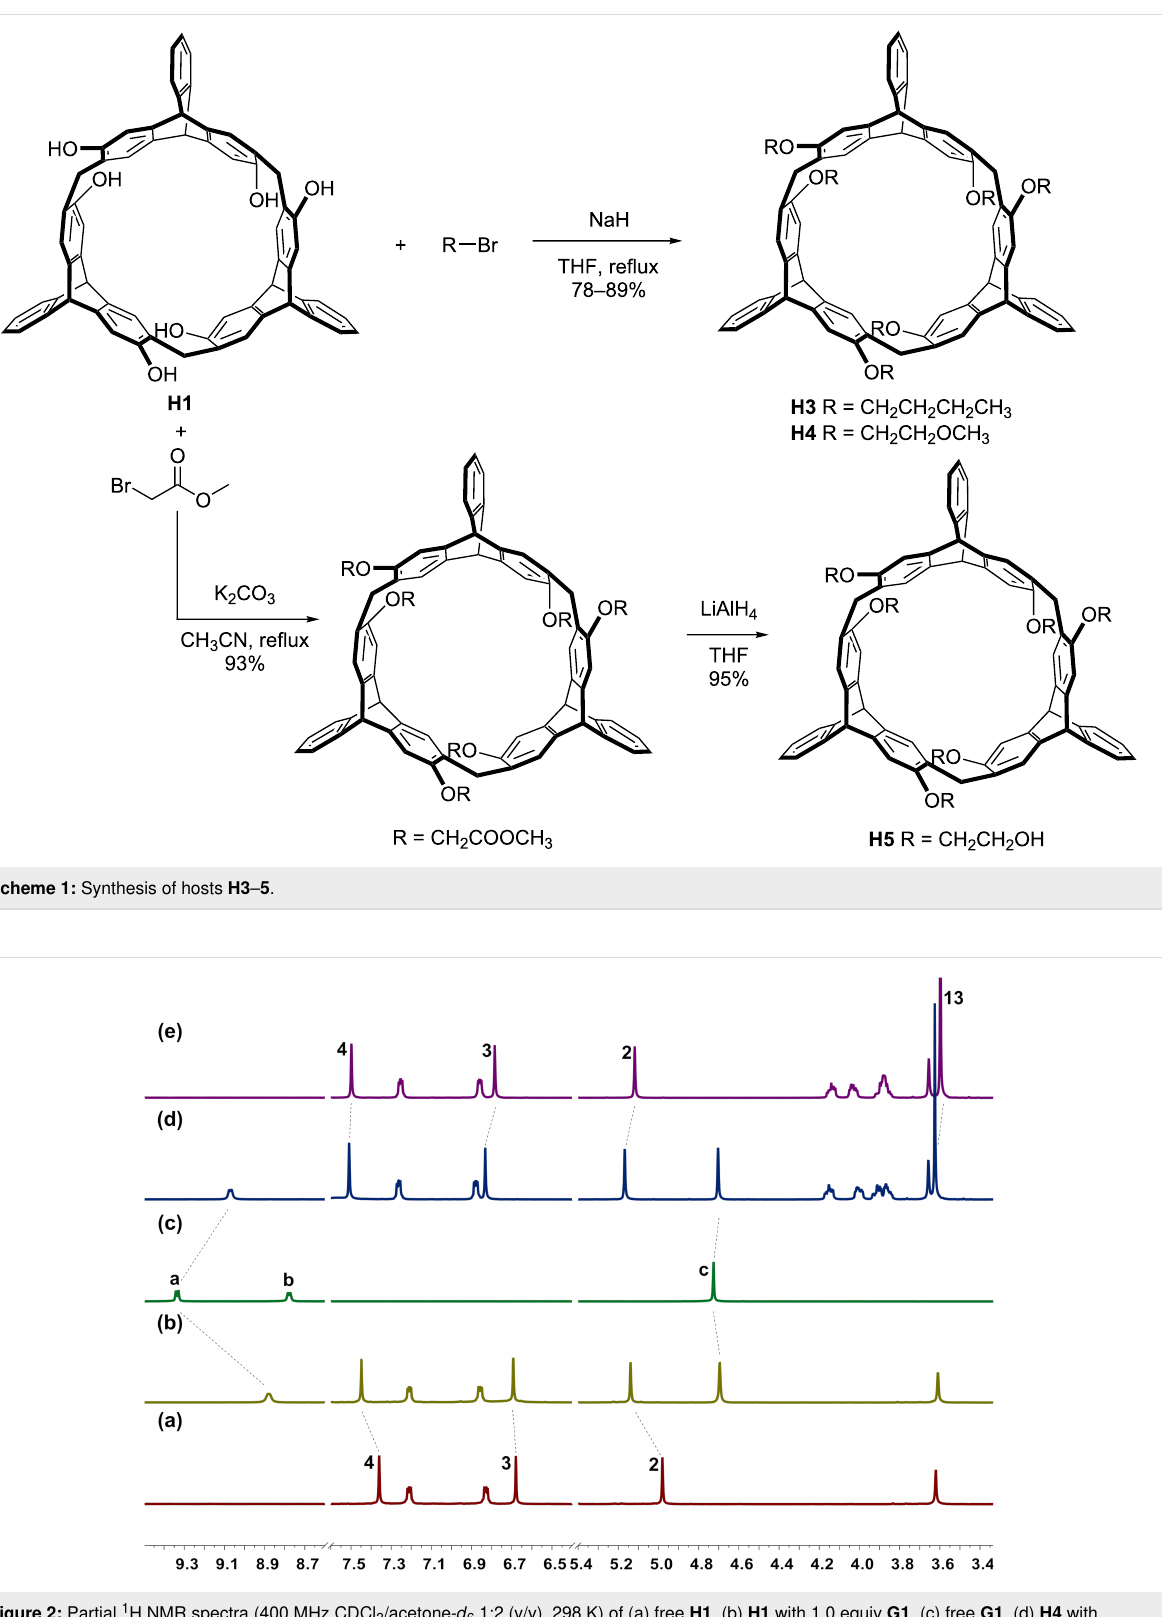
Figure 2: Partial 1 H NMR spectra (400 MHz CDCl 3 /acetone- d 6 1:2 (v/v), 298 K) of (a) free H1 , (b) H1 with 1.0 equiv G1 , (c) free G1 , (d) H4 with 1.0 equiv G1 , (e) free H4 . [ H1 ] 0 = [ H4 ] 0 = [ G1 ] 0 = 2.0